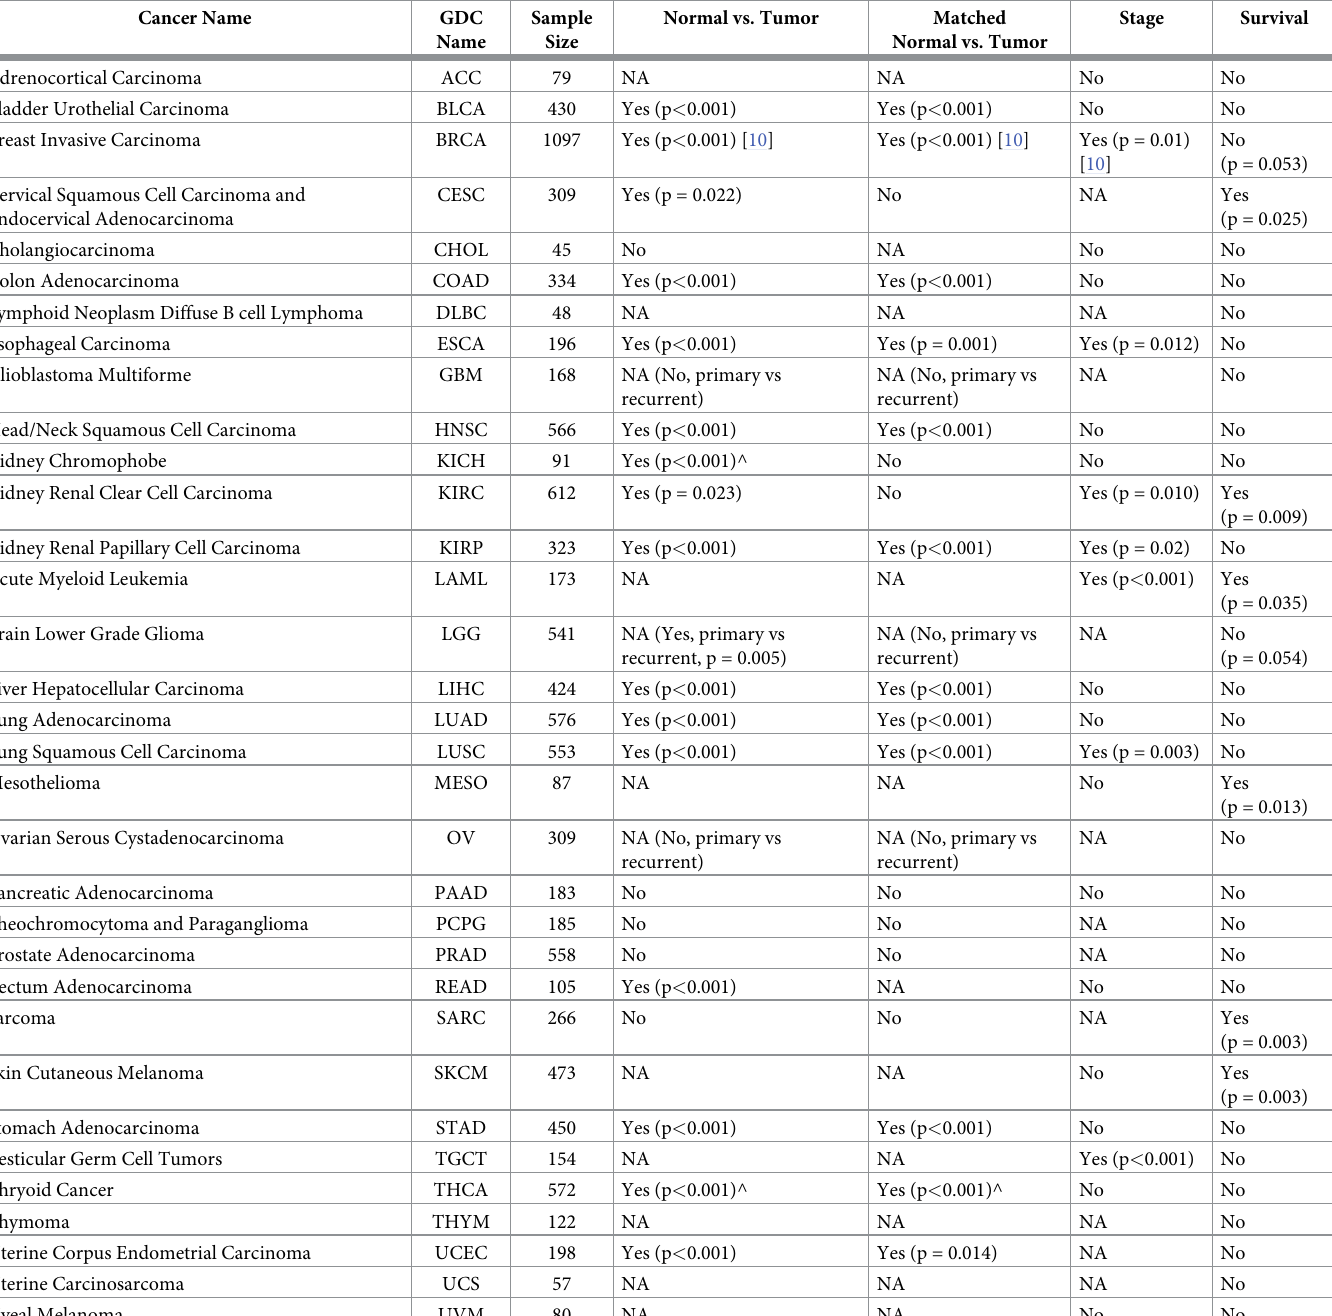
Table 1. Results of DNMT3B7 expression across all cancer